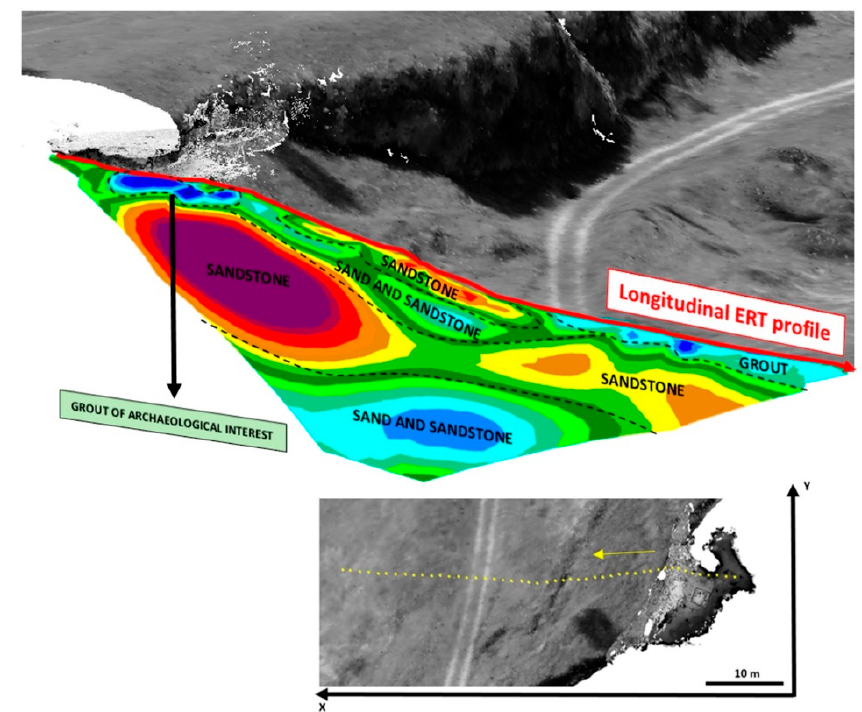
Remote Sens. 2019 , 11 , x FOR PEER REVIEW Figure 11. Results obtained from the longitudinal Electrical Resistivity Tomography profile (profile 1).